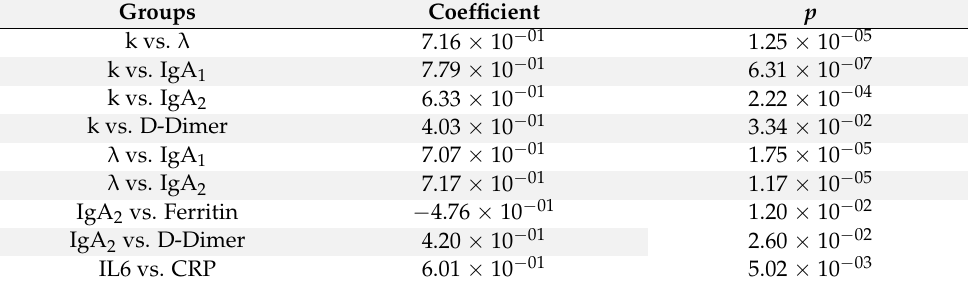
Figure 2. ROC curves for the selected salivary biomarkers ( A ); evolution of the Aikake Information Criterion during a stepwise logistic regression performed on all the measured parameters ( B ); ROC curve calculated using the selected variables ( C ); AUC values and 95% confidence intervals for all the computed ROC curves ( D ). Table 4.